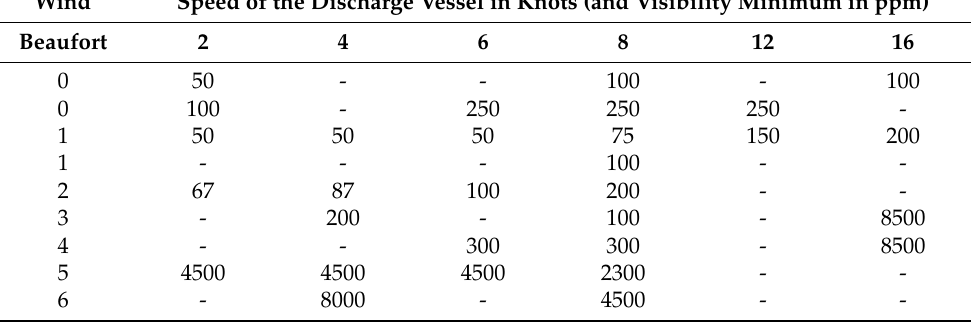
Table 5. Minimum discharge visible with win and speed of discharge (Data from Fingas et al., 1999